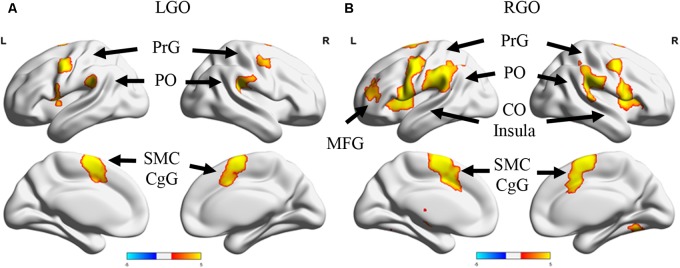
Activation maps for run 0 during the first session. Surface projections of the activation maps showing regions that were activated during (A) imagined left hand gripping and opening (LGO) and (B) imagined right hand gripping and opening (RGO). Activation maps were generated using a threshold value of p < 0.05 corrected for multiple comparisons using family wise error correction at the cluster level. Note that some regions in the cerebellum were also activated but were not shown in the figure. PrG, precentral gyrus; PO, posterior operculum; CO, central operculum; SMC, supplementary motor cortex; CgG, cingulate gyrus; MFG, middle frontal gyrus.